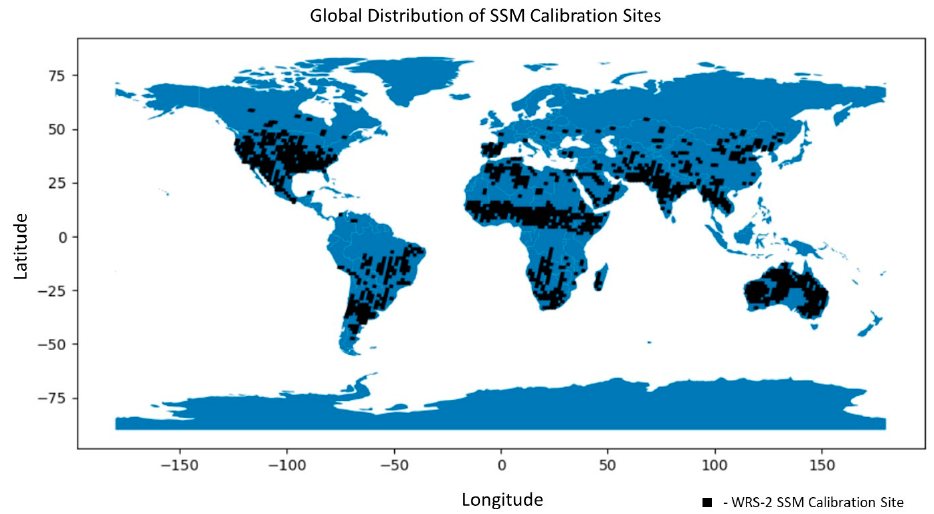
Figure 4. SSM geometric calibration sites are displayed. Sites are well distributed throughout the globe.